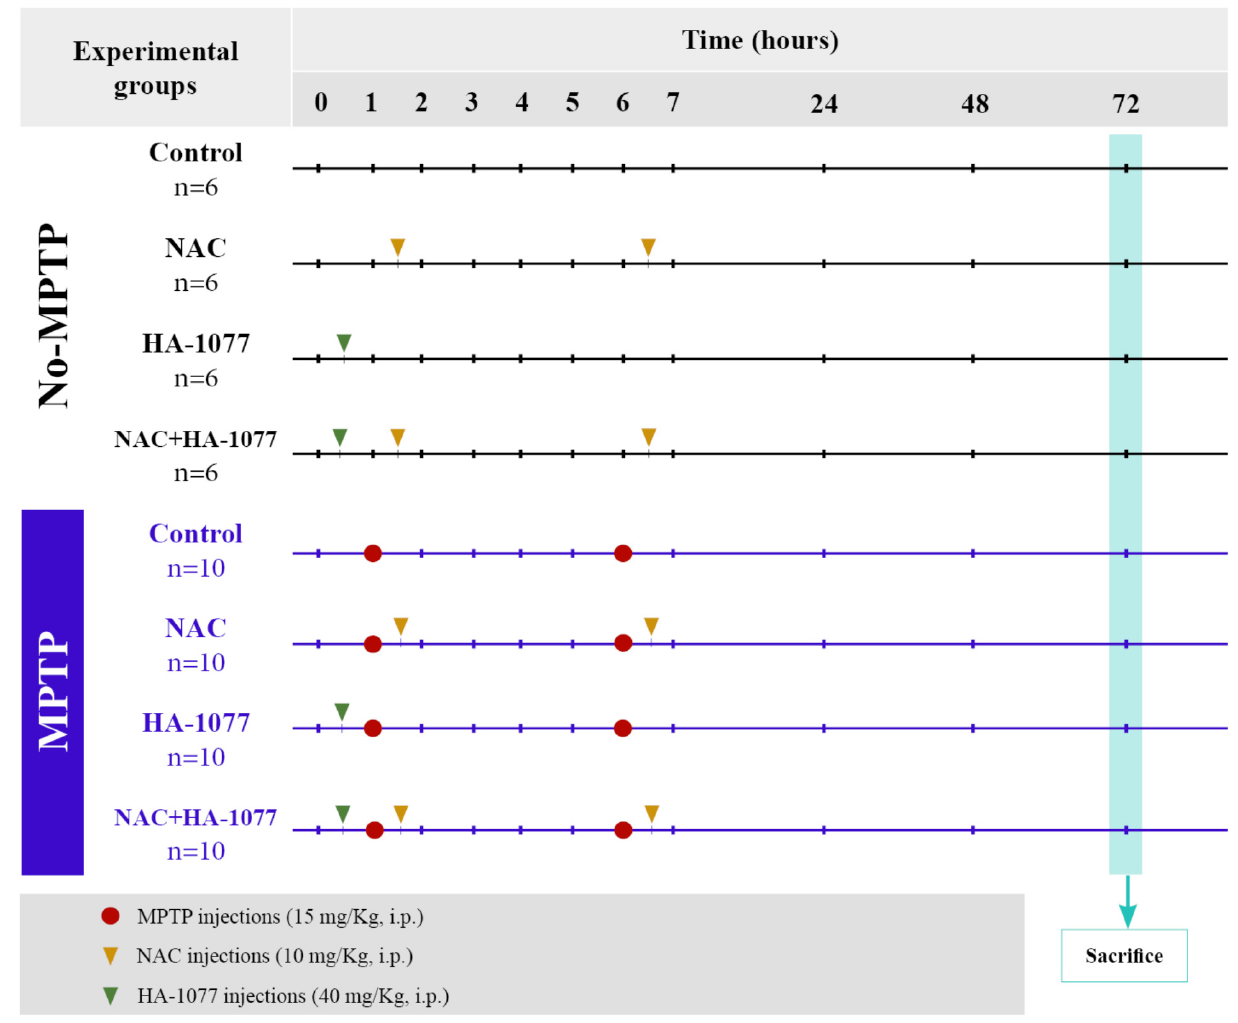
FIGURE 1 | Scheme of the experimental design and distribution of the groups and animals with their respective